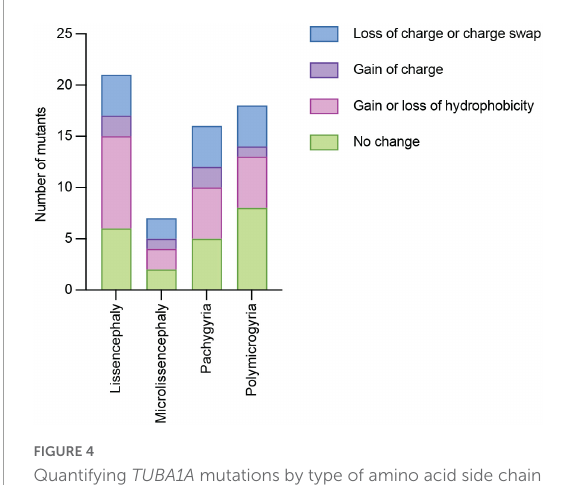
FIGURE4 Quantifying TUBA1A mutations by type of amino acid side chain change. TUBA1A mutations were sorted by the type of amino acid change that occurs in patients (loss of charge or charge swap, gain of charge, gain or loss of hydrophobicity, or no change in charge or hydrophobicity). TUBA1A mutations were also sorted by the primary cortical malformation resulting from each mutation (lissencephaly, microlissencephaly, pachygyria, or polymicrogyria). For each cortical malformation, the number of mutations that qualify as one (or multiple) of these types of amino acid changes were